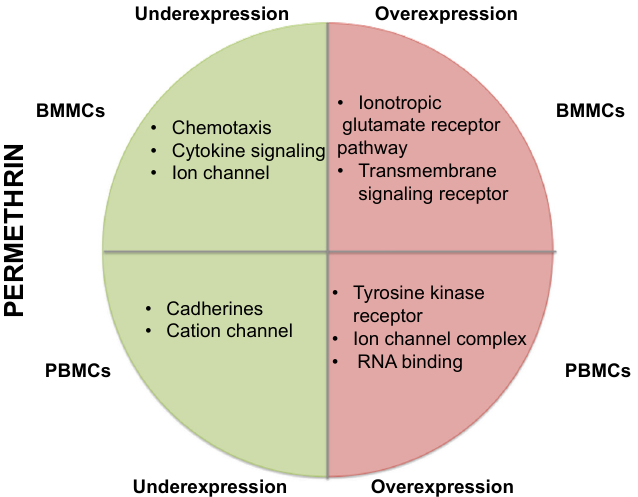
Figure 3. Summary of over ‐ representation test results of genes with altered expression in BMMCs and PBMCs exposed to permethrin. The green section shows cellular functions associated with genes with underexpression and the red section with genes with overexpression. The upper part displays the results of BMMCs and the lower part shows the results of